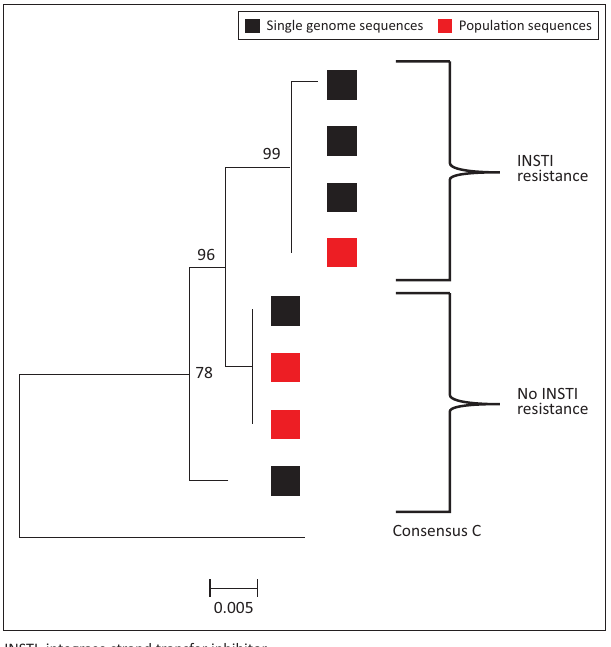
FIGURE 2: Neighbour joining p-distance phylogenetic tree of integrase nucleotide sequences generated from population and single genome